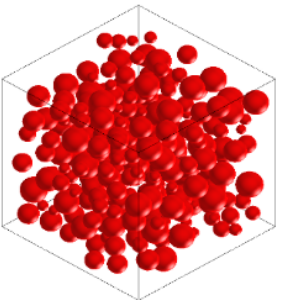
Figure 10. Two-dimensional random aggregate model of concrete.